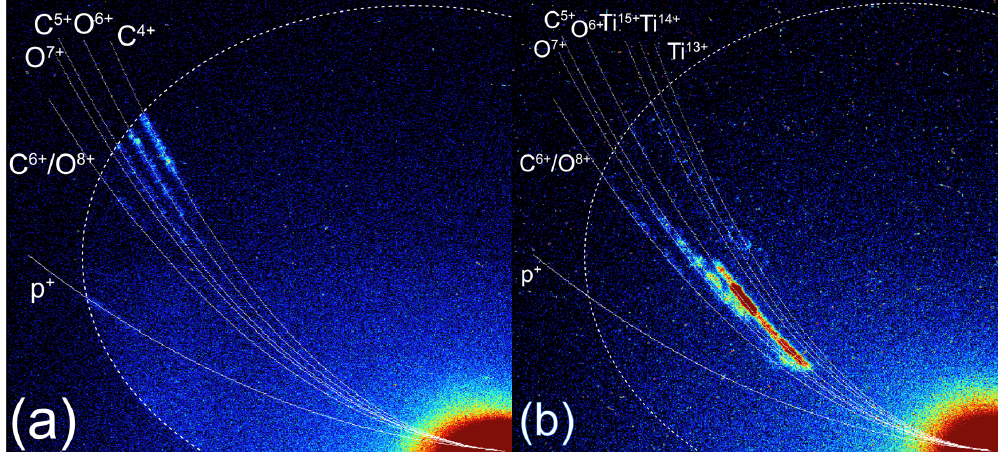
Figure 5. Images of the micro channel plate (MCP) for the Thompson parabola (TP) spectrometer showing parabolic tracks for each ion charge to mass ratios. The brightest points on the bottom right of the images are fixed to the origins of the parabolic curves. The dashed circle shows the MCP size, which determines the minimum detectable energy of ions. (a) shows the ion tracks obtained without CW laser heating, and (b) shows ion tracks obtained with CW laser heating.